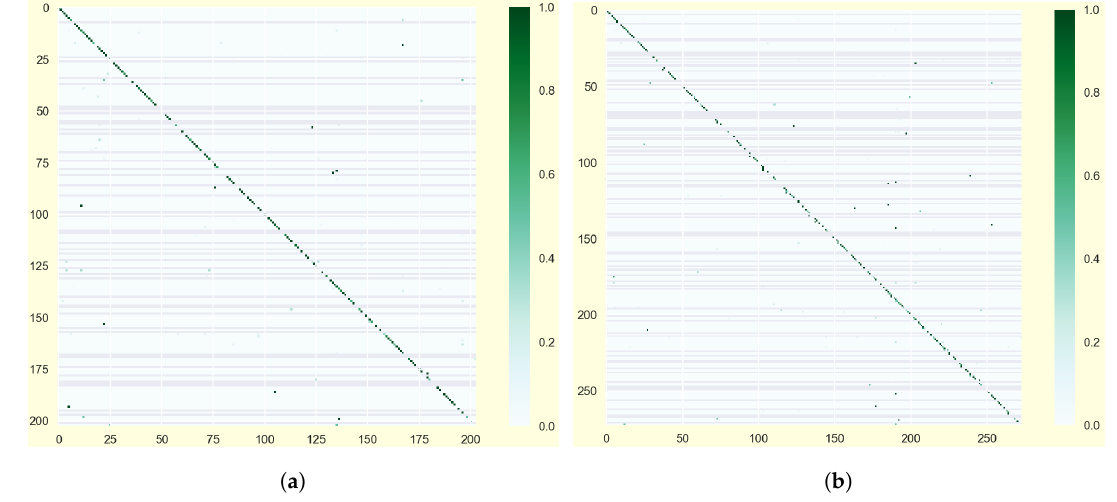
Figure 7. Exemplary confusion matrices for ( a ) CNN F 3, L 1 and ( b ) CNN F 3, L 2